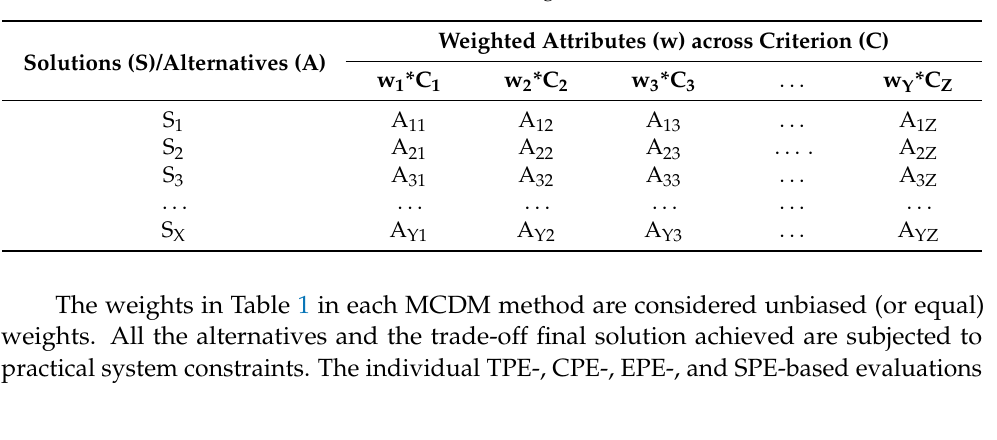
Table 1. Generic decision matrix in MCDM